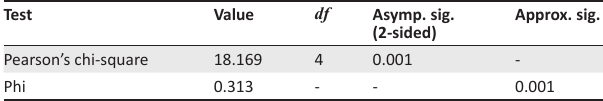
TABLE 7: Stepladder technique versus step-by-step decision-making